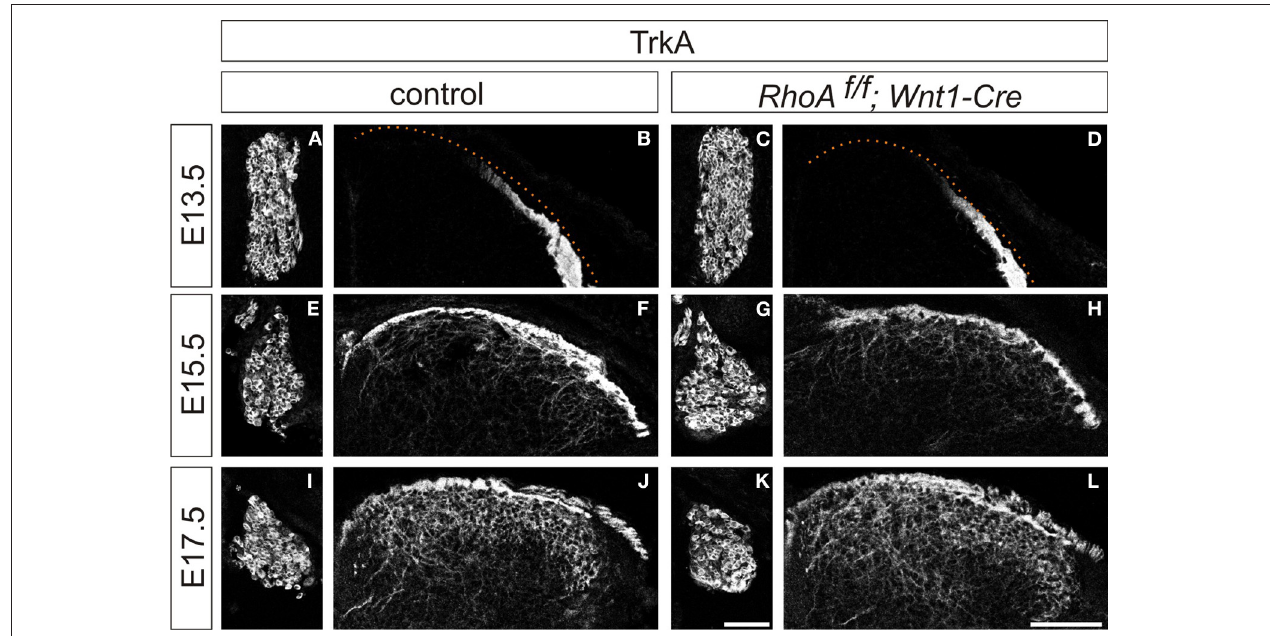
Wnt1-Cre embryos at E15.5 and E17.5. ( B,F,J and D,H,L ) TrkA + cutaneous axonal projections in the spinal cord of control and RhoA f / f ; Wnt1-Cre embryos at E15.5 and E17.5. Scale bars, 100 µ